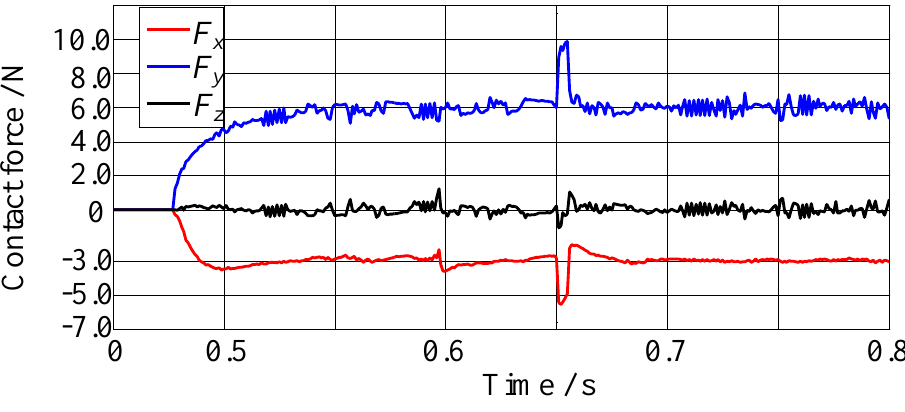
Figure 17. The force tracking results when environment position changed at 0.65